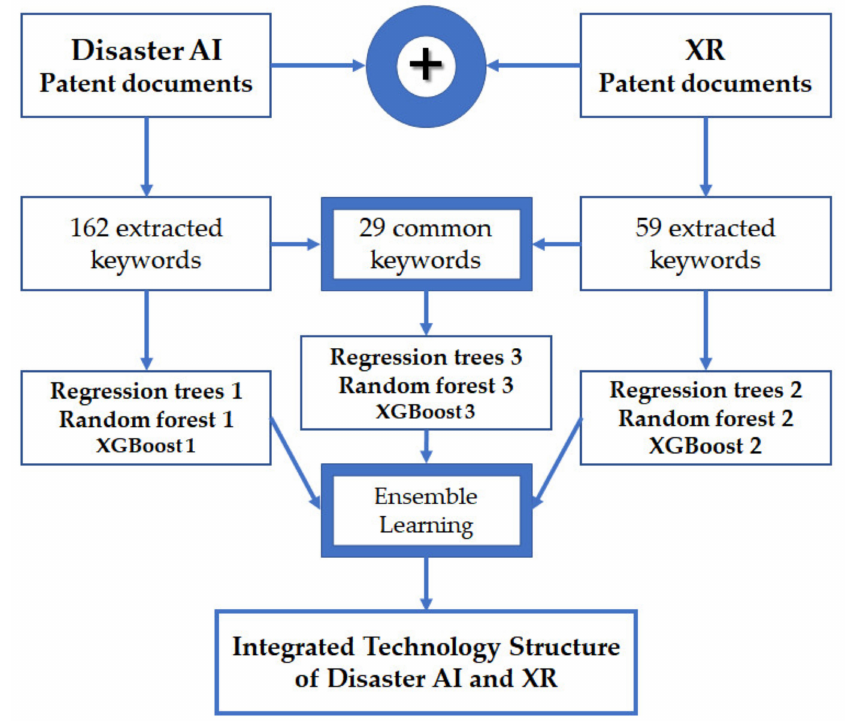
Figure 4. Technology integration and analysis of disaster AI and